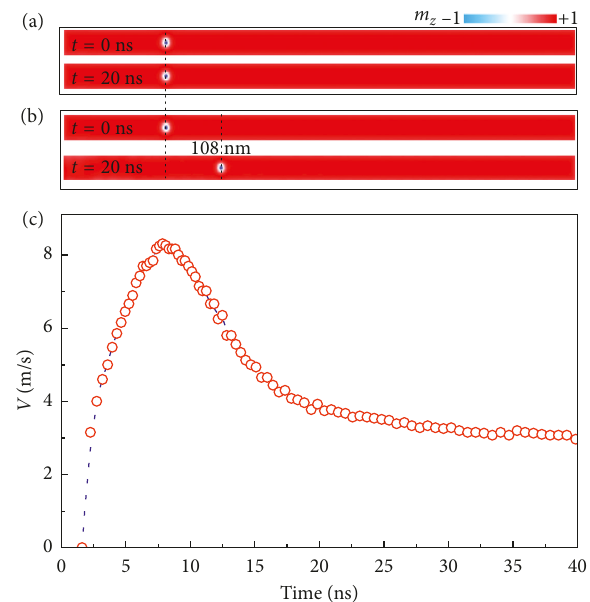
Figure 1: The snapshots of the propagation of the skyrmion on the nanostrip and the propagation of the skyrmion driven by the SW injection with the frequencies (a) 40 GHz and (b) 60GHz. (c) The velocity of a skyrmion as a function of time for the SW with frequency f (cid:31)